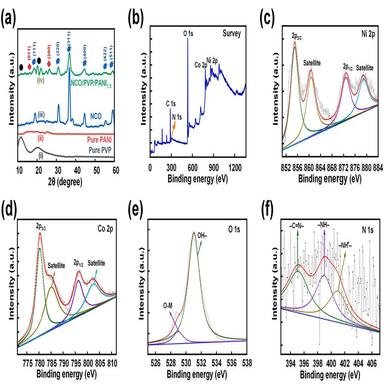
(a) XRD patterns of (i) pure PVP, (ii) pure PANI, (iii) NCO, and (iv) NCO/PVP/PANI1.5. (b) XPS survey spectra of NCO/PVP/PANI1.5 composite, and high-resolution XPS spectra of (c) Ni 2p, (d) Co 2p, (e) O 1 s, and (f) N 1 s of NCO/PVP/PANI1.5 composite.